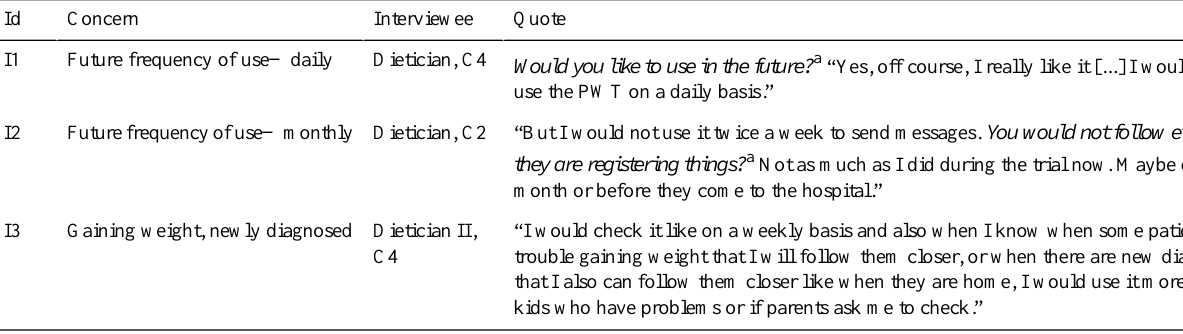
Table 12. Illustrative quotes related to using the professional web tool: interest in future